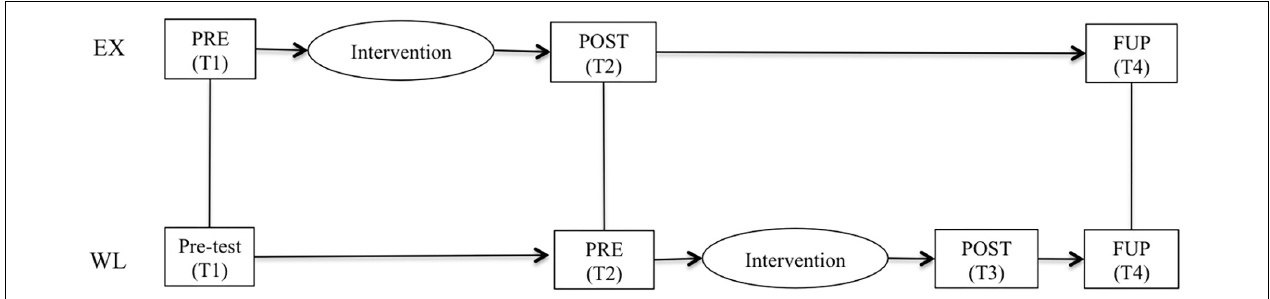
FIGURE 1 | Experimental design of the study. EX experimental group; WL waiting list-control group; PRE pre-assessment; POST post-assessment; FUP follow up-assessment; Tl time 1; T2 time 2; T3 time 3; T4 time 4.